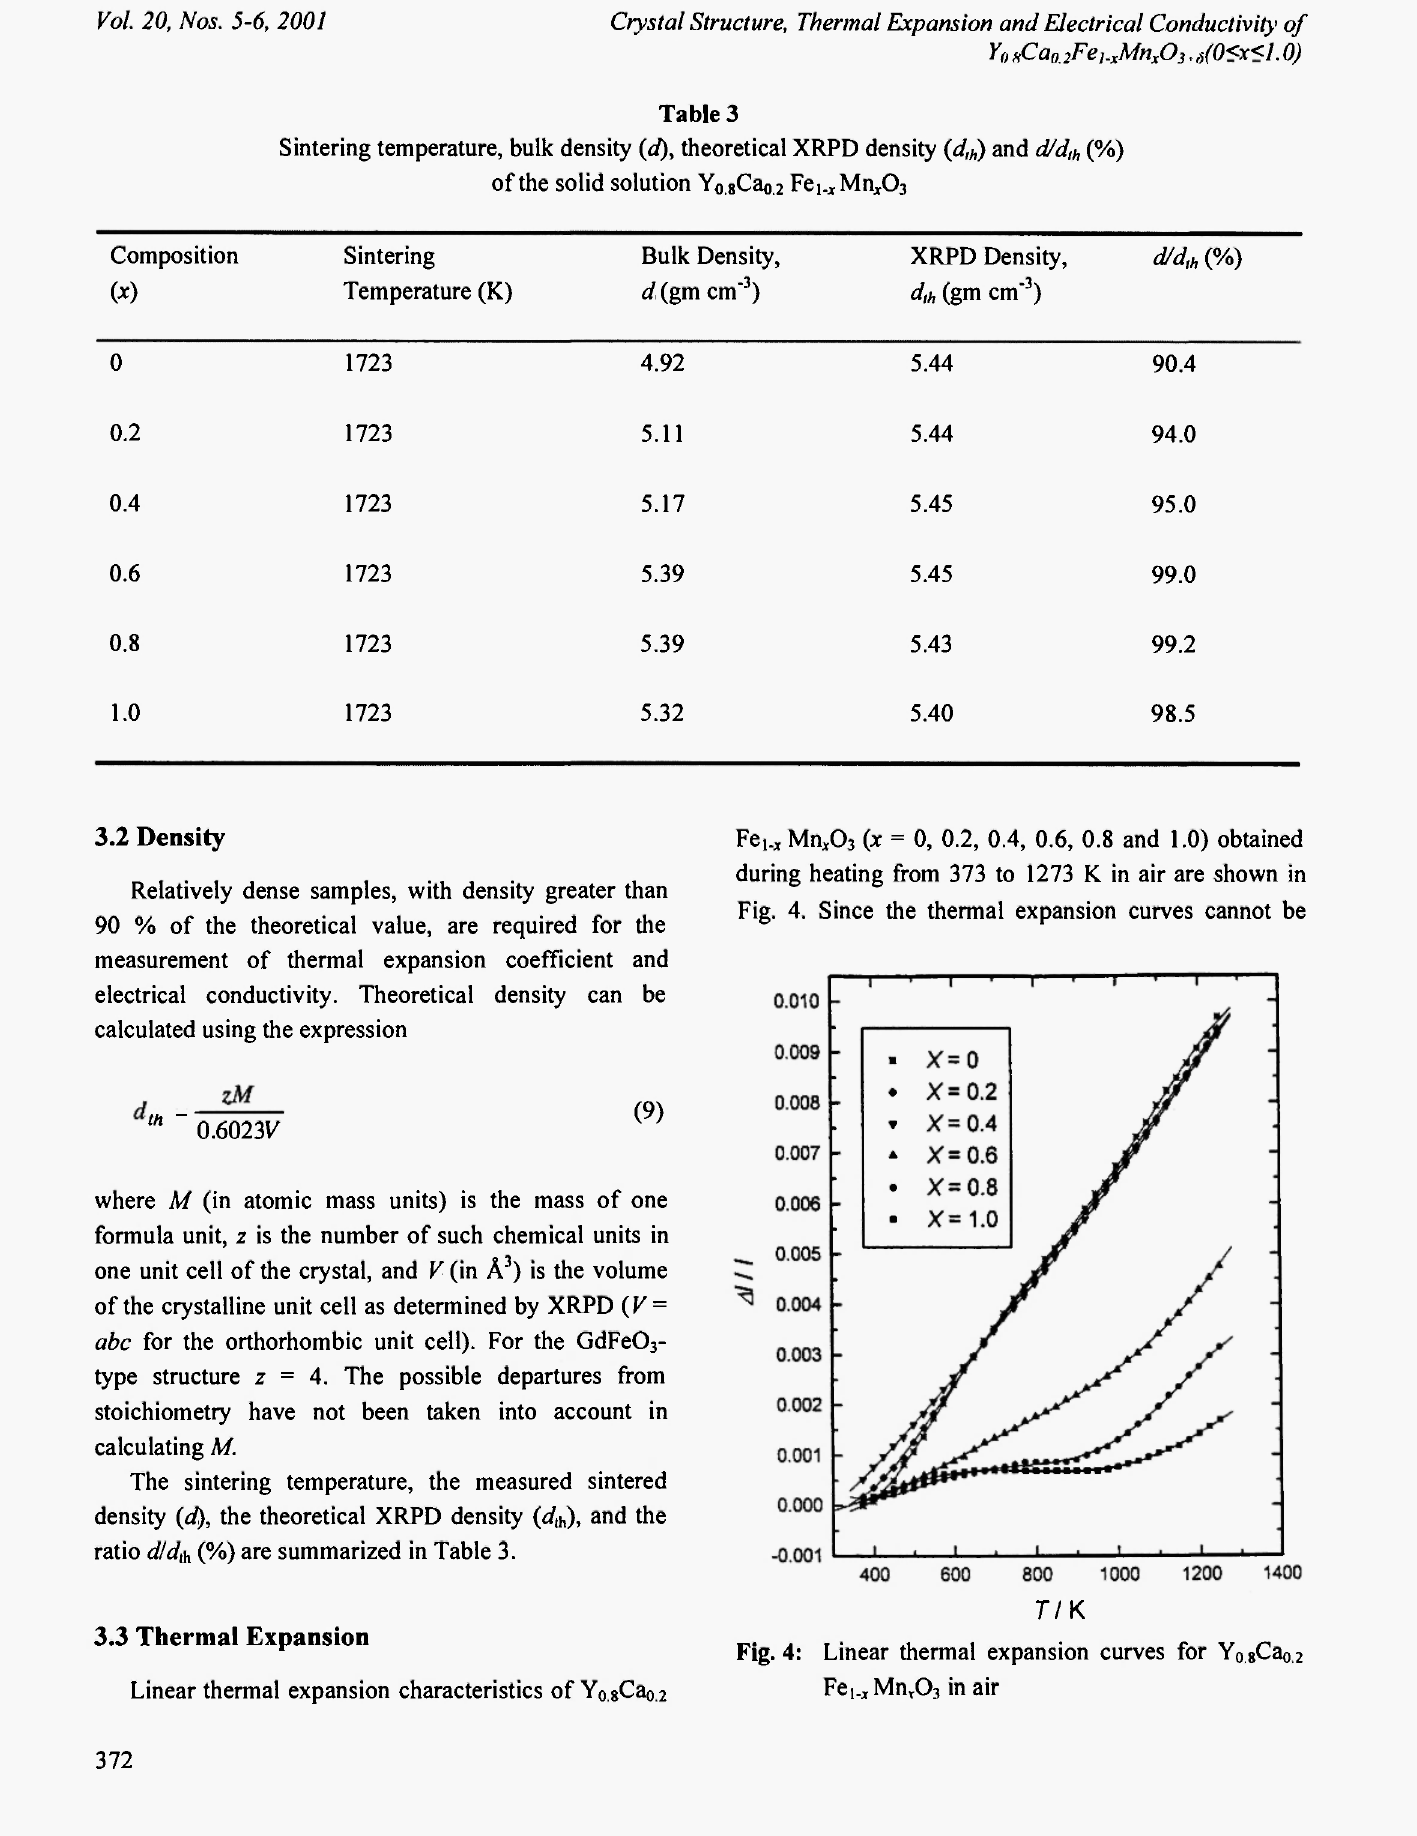
Fig. 4: Linear thermal expansion curves for Y 0 .8Ca 0